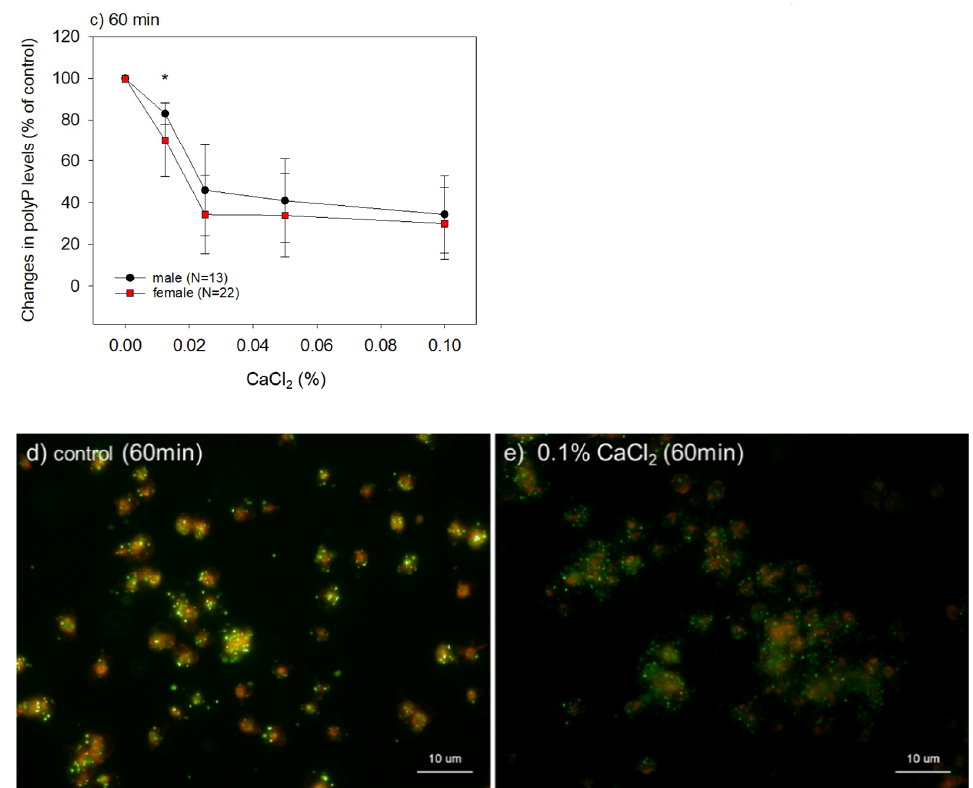
Figure 5. ( a – c ) Concentration-response effects of CaCl 2 on platelet polyP levels in the male and female groups. The platelet polyP levels were quantified at ( a ) 15, ( b ) 30, and ( c ) 60 min after 0.0125–0.1% CaCl 2 stimulation ( n = 13 (male group) or 22 (female group)). The asterisks represent statistically significant difference between male and female groups at the same CaCl2 concentrations ( p < 0.05). ( d , e ) Cytochemical visualization of polyP particles in platelets derived from a male donor. Platelets were stimulated with 0.1% CaCl 2 for 60 min ( e ) or Milli-Q water (10% volume) as control ( d ). The polyP and polymerized actin were stained green and red, respectively. Similar observations were obtained from other three independent experiments using samples from both genders.